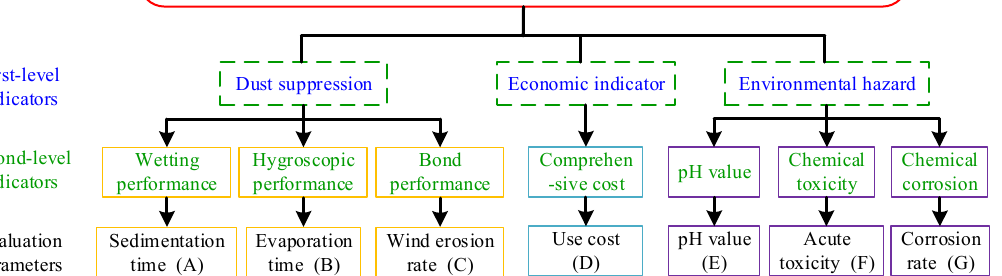
Figure 1. Schematic diagram of comprehensive evaluation index system.